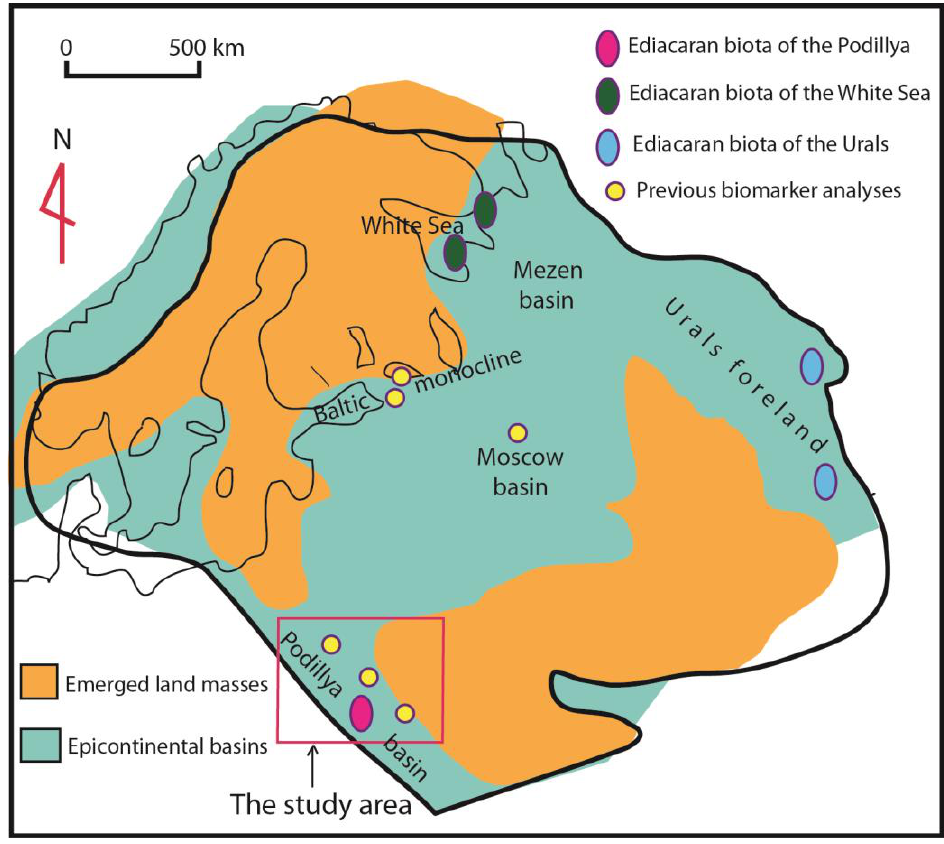
Figure 1. Paleogeography and localities of Ediacaran phosphate deposits in the East European Platform (modified after [24,58] and Baltica at ~550 Ma (modified from [59]).